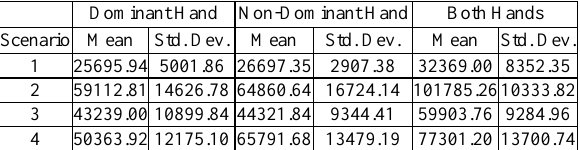
Table 5. Mean and Standard Deviation values for Fixation Duration Dominant Hand Non-Dominant Hand Both Hands Scenario Mean Std. Dev. Mean Std. Dev. Mean Std. Dev.